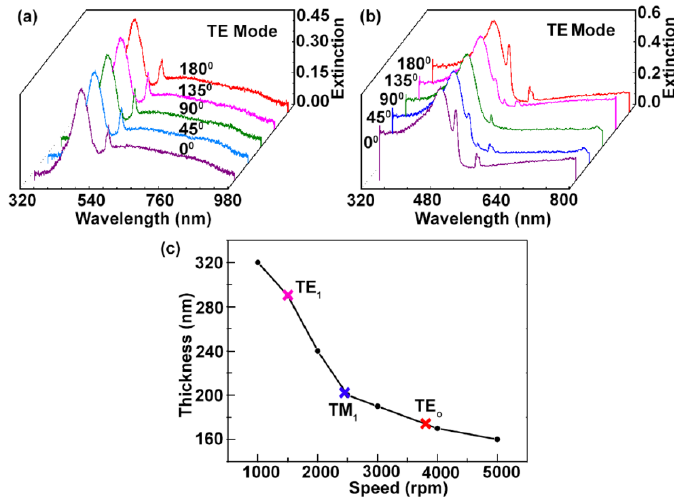
Figure 4. Optical characterization of the circular periodic grating and regular periodic grating. ( a ) Extension spectra of the circular grating at different polarization angle for TE 0 mode. ( b ) Regular grating extinction curve indicating polarization at various angles for TE 0 mode. ( c ) Thickness of the F8BT film as a function of spin-coating speed. The red, blue, and pink colors in the F8BT thickness curve represent TE 0 ,TM 1 and TE 1 mode availability, according to the variation of the film thickness.